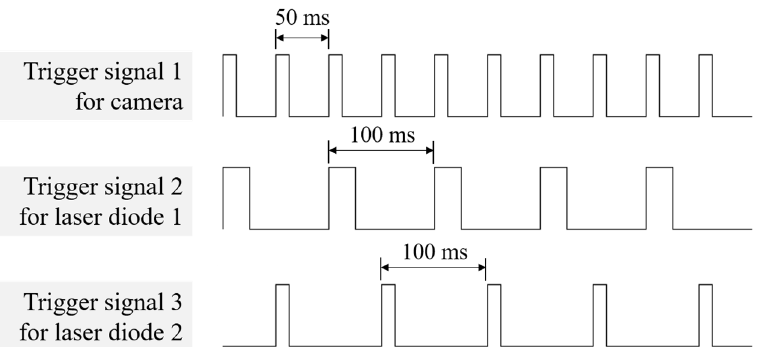
Figure 2. Trigger signals for synchronized operation of the camera and the two laser diodes for NIR dual-channel fluorescence imaging.